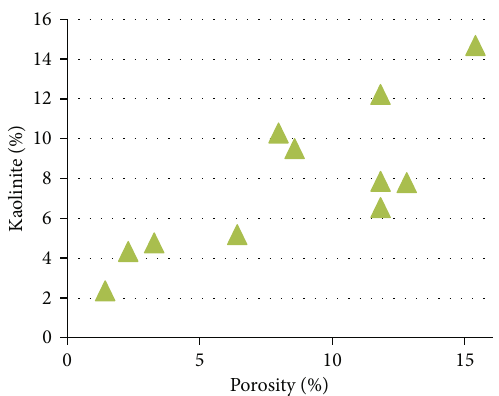
Figure 8: Linear correlation between the kaolinite content and porosity, in the upper turbidite sandstones (Algy ő